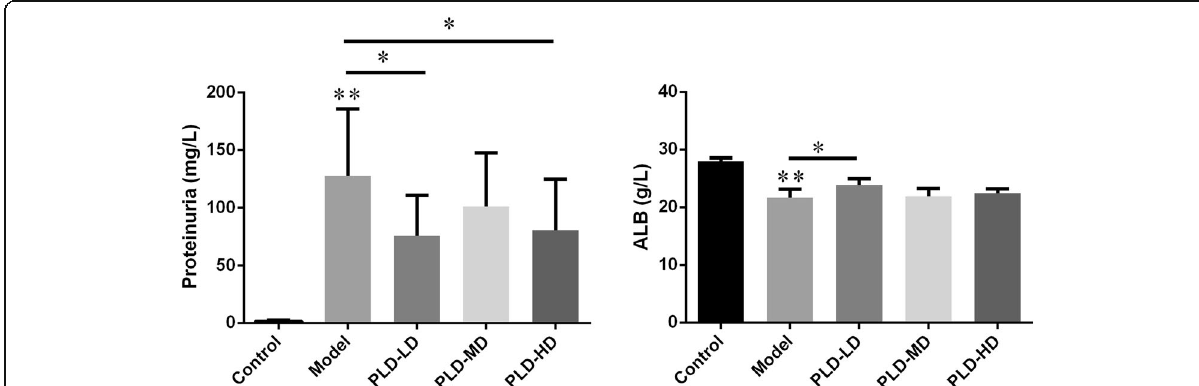
Fig. 1 Evaluation of proteinuria and serum ALB concentration. The 24 h urine and serum ALB concentrations were collected from experimental rats. Data ( n = 6) are presented as the mean ± SD. * p < 0.05; ** p < 0.01